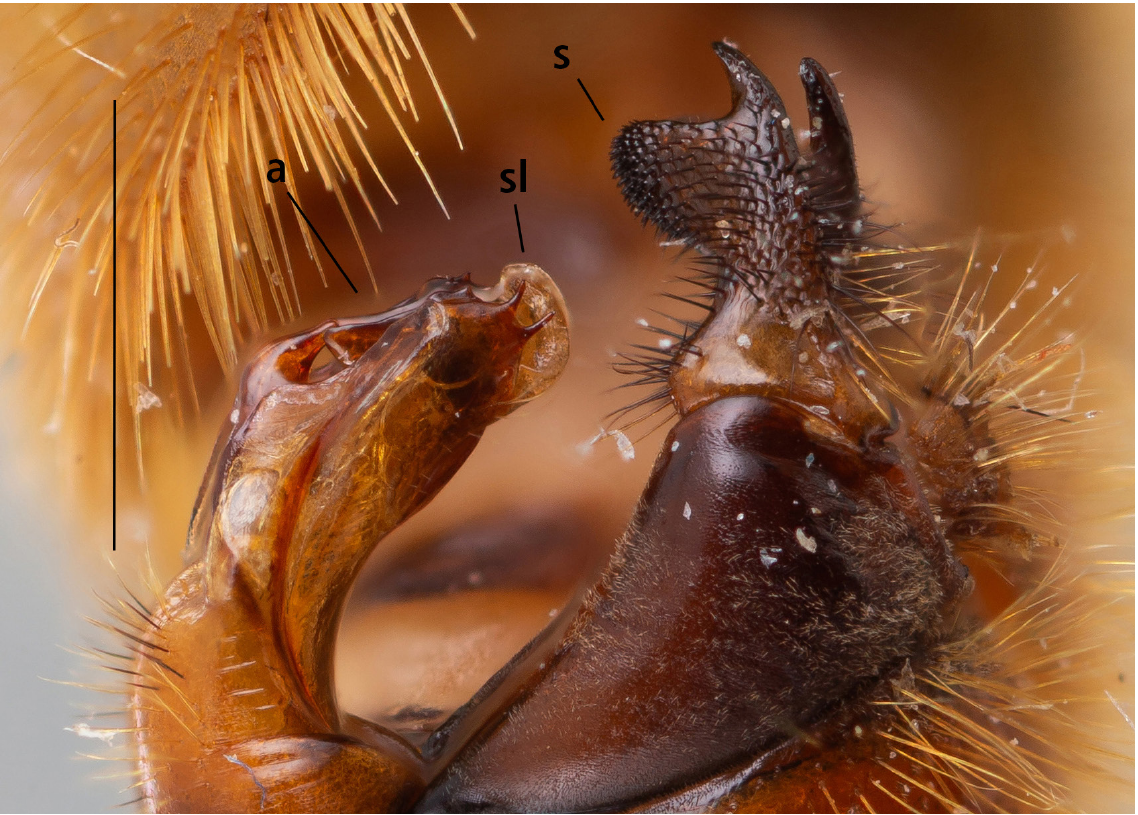
Fig. 7. Milesia cretica Bot & van Steenis sp. nov. (SBH), male genitalia in lateral view. Collected on Crete, Imbros Gorge, 17 October 2017, leg. and coll. S. Bot. Abbreviations: a = aedeagus; s = surstylus; sl = superior lobe. Scale bar = 1